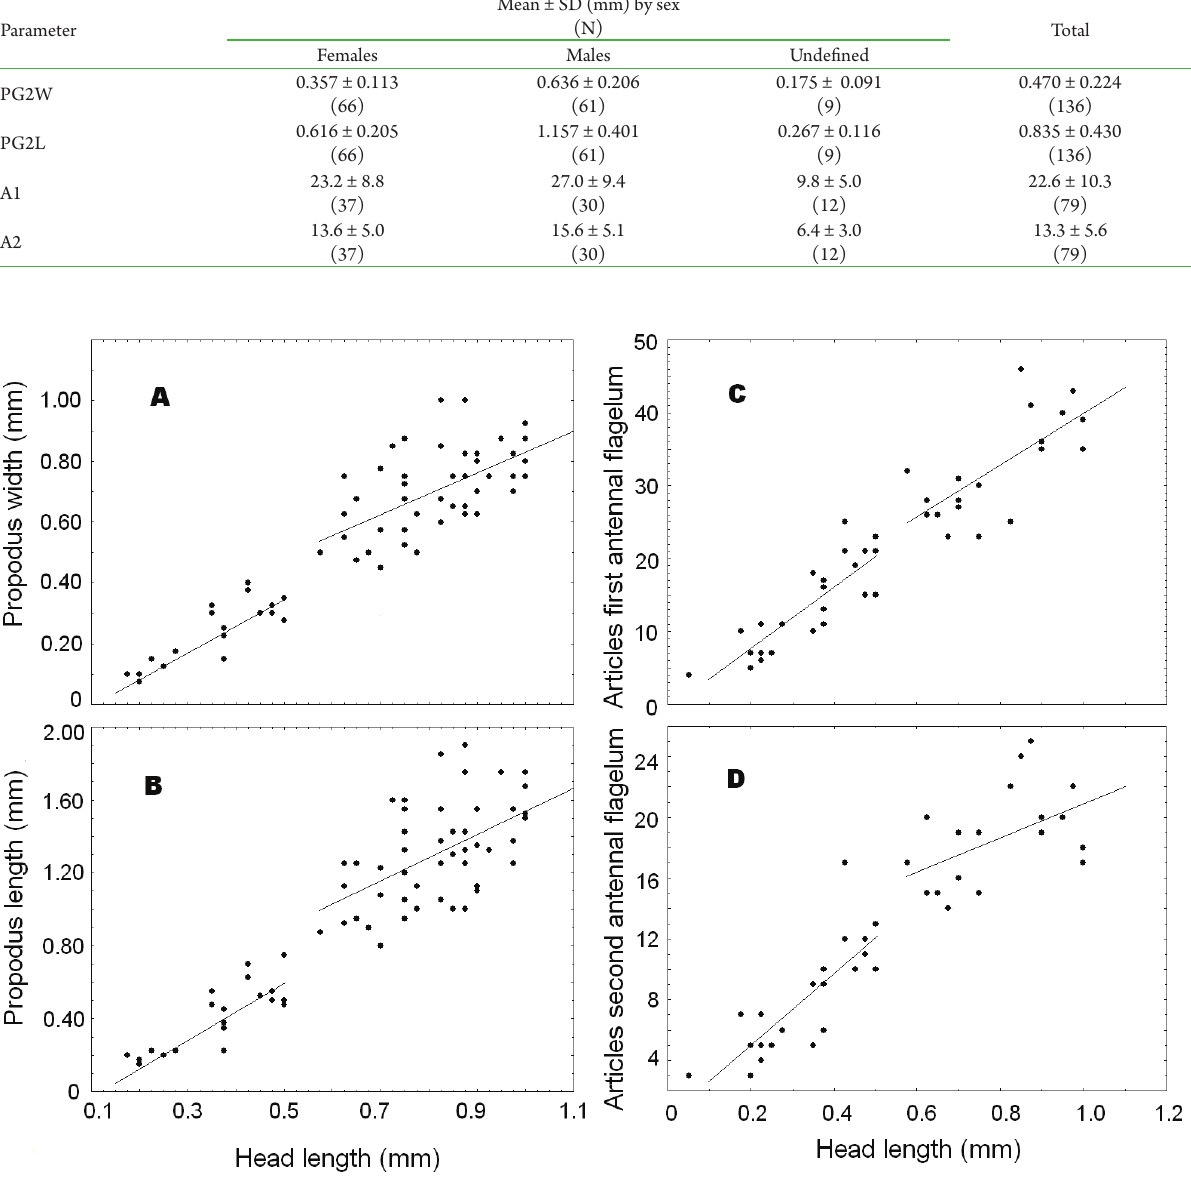
Figure 7. Male relative growth of the width (A) and length (B) of the propodus of the second gnathopods; and the number of articles in the first (C) and second (D) pair of antennal flagella . Discontinuity of the regression lines represents the size-range at which maturity is reached in males of Quadrivisio lutzi . Gnathopods were measured from 70 specimens (61 males and 9 of undefined sex) and flagella articles were counted from 42 specimens (30 males and 12 of undefined